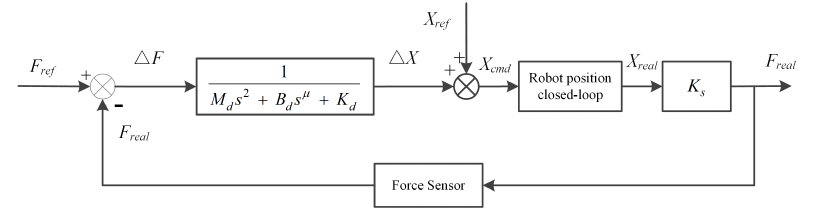
Figure 2. Robot manipulator FOIC control system